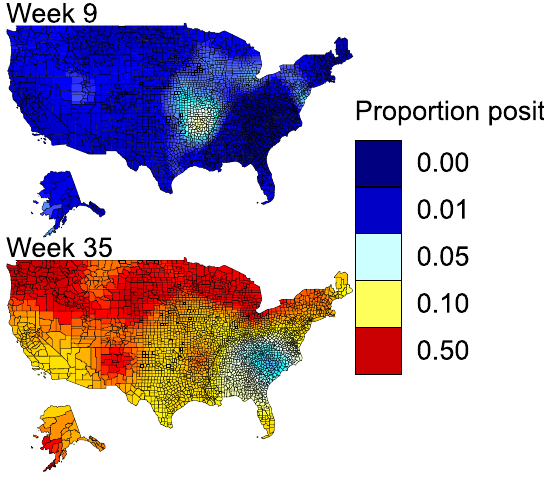
Figure 1. Example of spatiotemporal predictions of IAV prevalence in mallards. The listed weeks roughly correspond to the first week of March and September, highlighting the low levels of IAV prevalence in Spring outside of a relative hot-spot in the Mississippi Alluvial Valley, as well as the wide-spread elevated prevalence in fall across the northern latitudes. Maps were produced in ggplot2 68 . Full predictions for all species and week combinations are available in Supplementary Material 2.